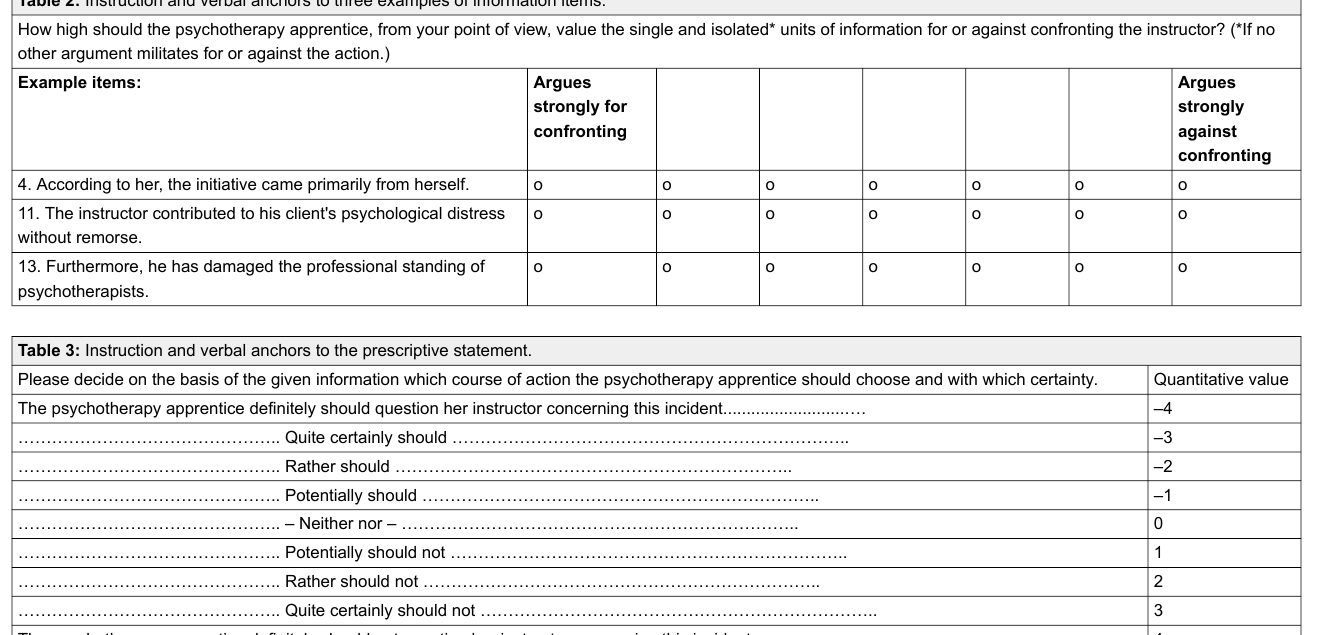
strongly for confronting